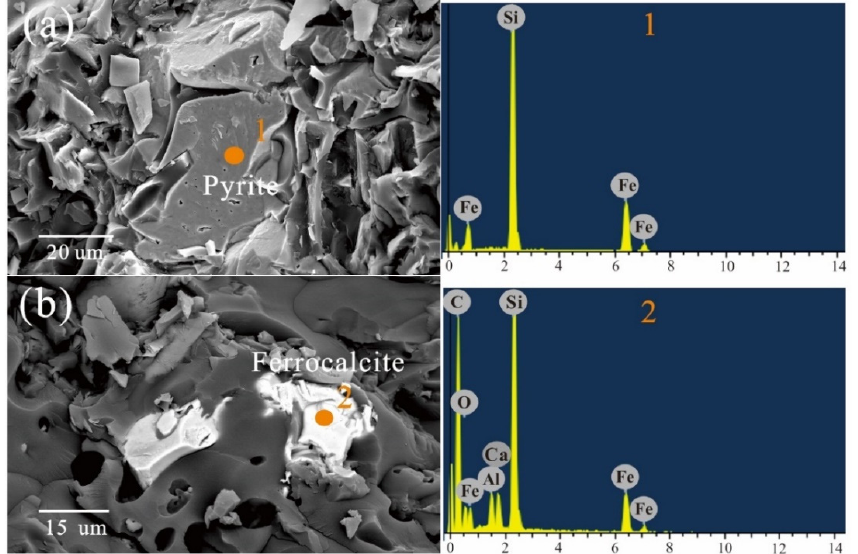
Figure 10. SEM-EDS results in sample M2. ( a ) pyrite minerals occured in sample M2, ( b ) ferrocalcite minerals occured in sample M2.